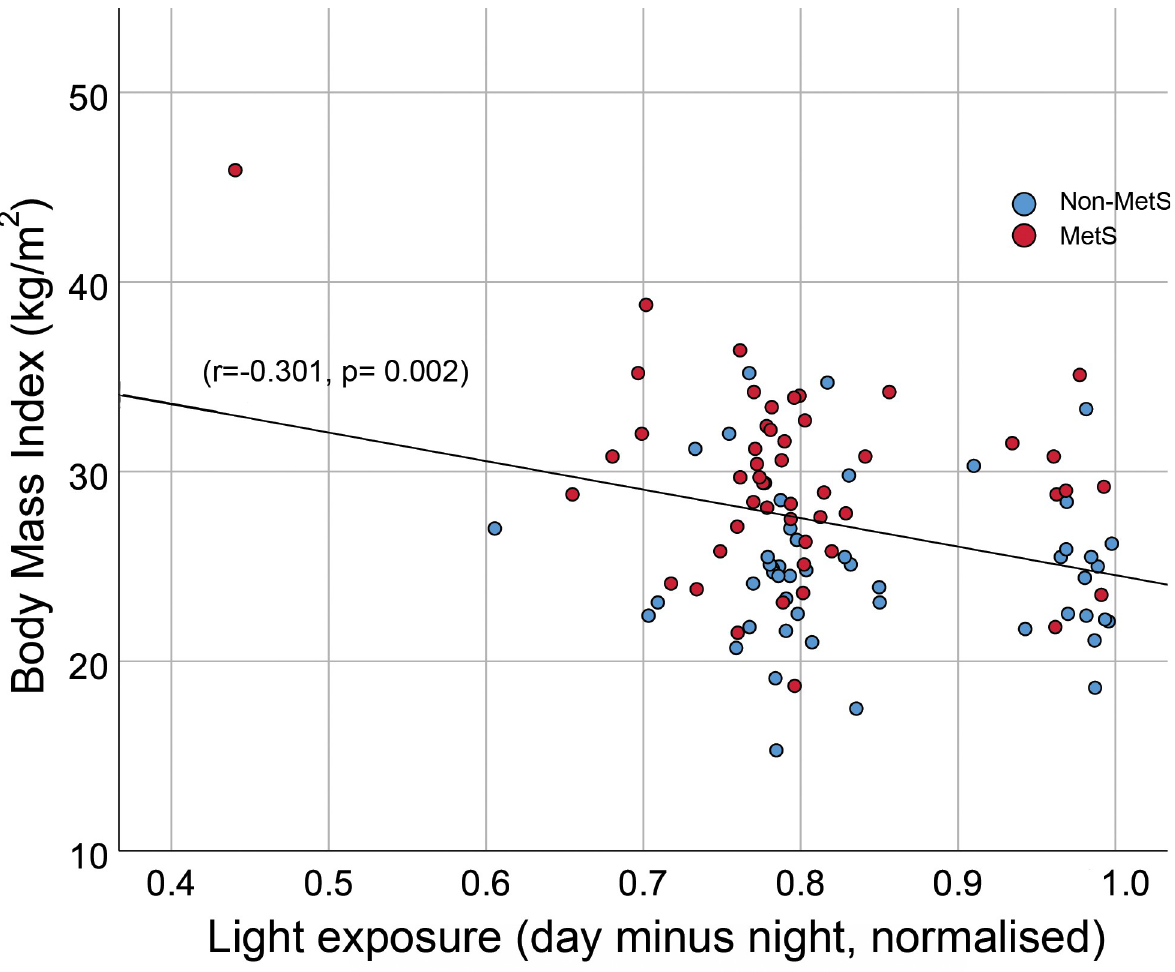
Fig 3. Scatterplot of BMI (body mass index) and normalised difference between diurnal and nocturnal light exposure. Data are presented with points for the MetS group (blue) and Non-MetS group (red). Across the entire sample, a line has been drawn to facilitate the calculated correlation